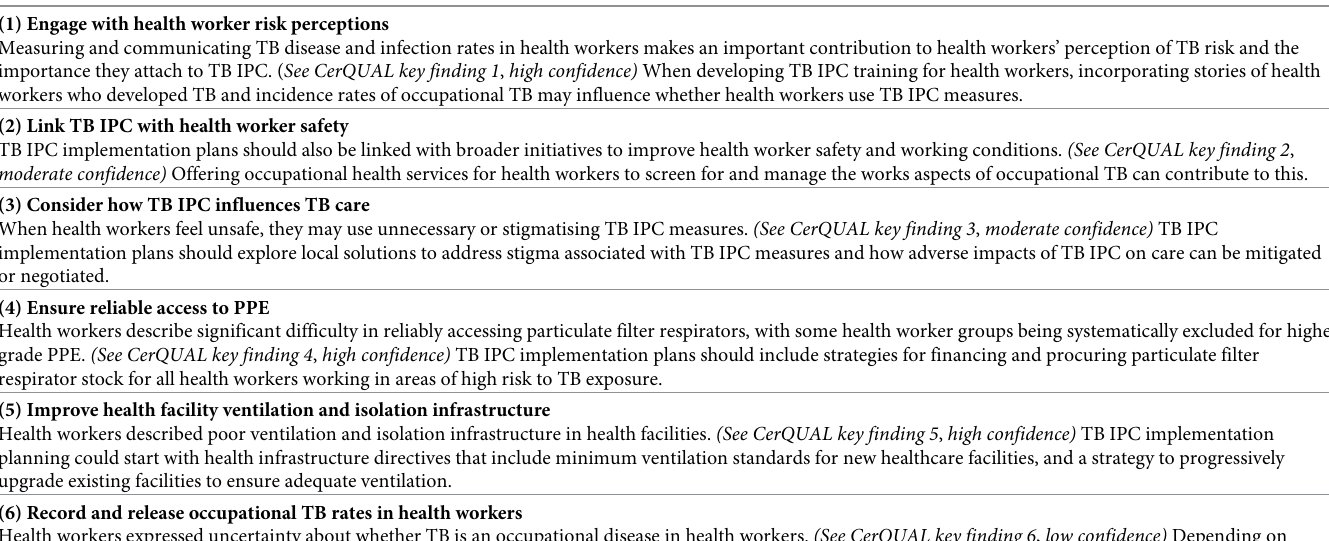
Table 4. Recommendations for translating the ten key findings of this qualitative evidence synthesis to TB IPC implementation